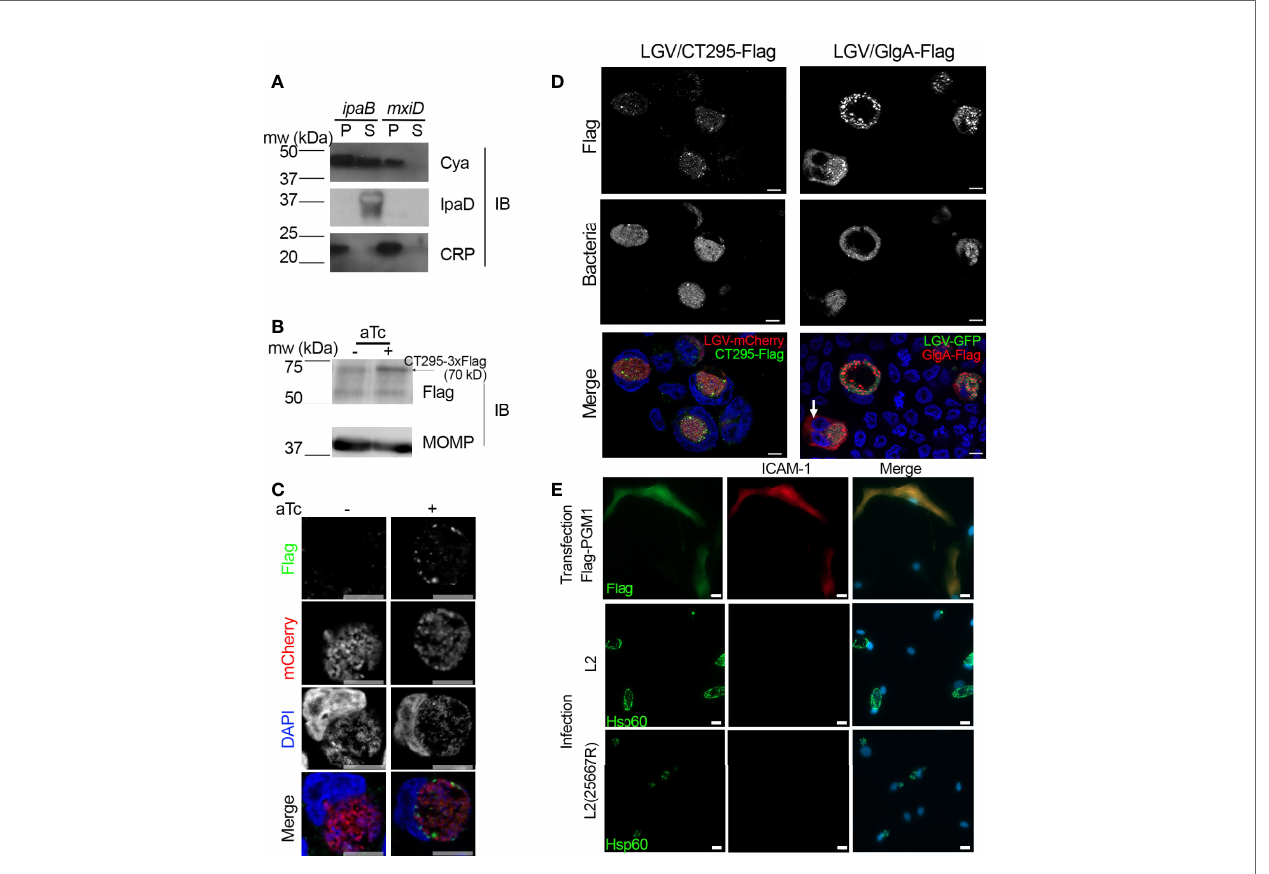
FIGURE 4 | CT295 amino-terminal sequence is recognized by the T3S machinery of S. fl exneri . (A) – The fi rst 22 amino acids of CT295 were fused to the Cya reporter protein and expressed in a S . fl exneri ipaB (constitutive T3S) or mxiD (defective T3S) strain. Exponential phase cultures expressing the reporter fusion protein were fractionated into supernatants (S) and pellets (P). Samples were resolved by SDS-PAGE, transferred to a PVDF membrane, and probed with anti-Cya (to detect the fusion protein), anti-IpaD ( Shigella secreted protein), or anti-CRP ( Shigella non-secreted protein) antibodies. (B) – Cells were infected with C. trachomatis L2 strain stably expressing mCherry with CT295-Flag (Tet-inducible promoter) for 40 h in the presence or not of 20 ng/ml anhydrotetracycline (aTc), before lysis and analysis by western blot. Upon induction, a weak band was detected upon aTc induction (arrow), the other bands correspond to background signal. The membrane was reprobed with antibodies against Chlamydia ’ s major outer membrane protein (MOMP) to control for equal loading. (C, D) – Cells infected with C. trachomatis expressing CT295-Flag in the absence of presence of 20 nM aTc were fi xed 24 hpi (C) or 40 hpi ( D , with aTc), permeabilized and stained with anti-Flag antibody. In panel (D) , cells infected with C. trachomatis L2 strain stably expressing GFP together with GlgA-Flag (endogenous promoter) were used for comparison. The white arrow points to GlgA-Flag detected in the cytoplasm of one infected cell. Bar is 10 m m. (E) – PGM1 de fi cient fi broblasts were transfected with Flag-PGM1 or infected with the indicated C. trachomatis L2 strain. Forty-eight hours later the cells were fi xed, permeabilized and stained with the indicated antibodies. Nuclei were stained with Hoechst (blue). Bar is 20 m